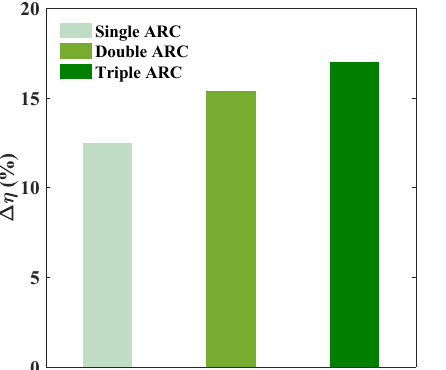
Figure 7. Relative efficiency changes utilizing various types of ARC techniques.